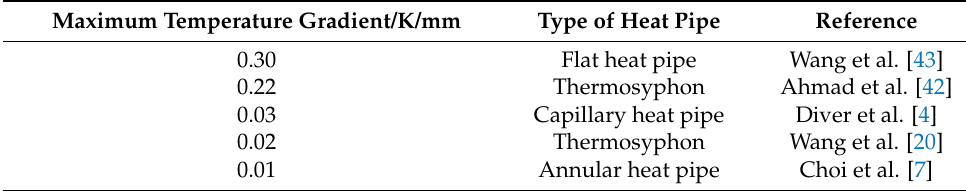
Table 3. Characteristics of heat pipes for isothermal performance of isothermal